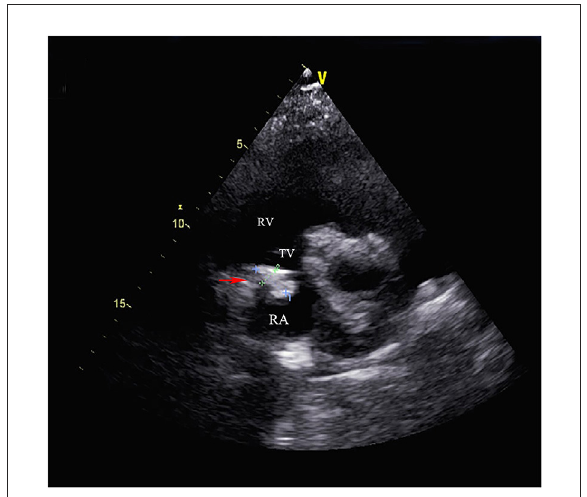
FIGURE1 Transthoracic echocardiography showed the cardiac mass (30mm x 28mm) located in the right atrium and the anterior tricuspid valve was partially obstructed by the mass but the flow velocity of tricuspid valve did not accelerate. (RA, right atrium; RV, right ventricle; TV, tricuspid